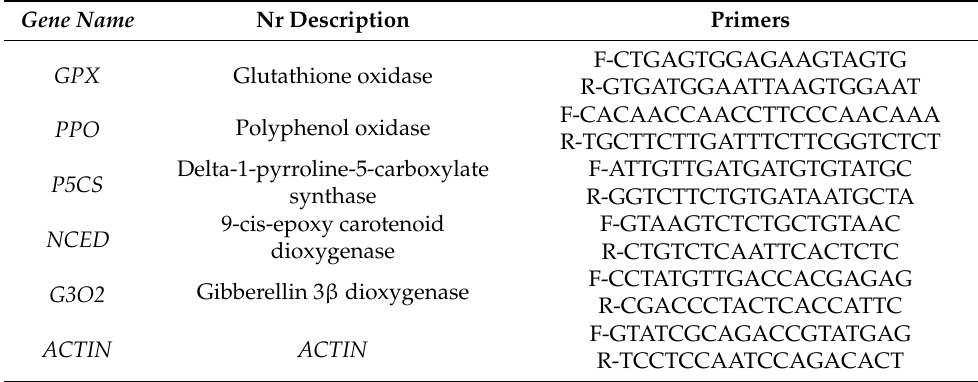
Table 1. Forward and Reverse Primers Used for qRT-PCR